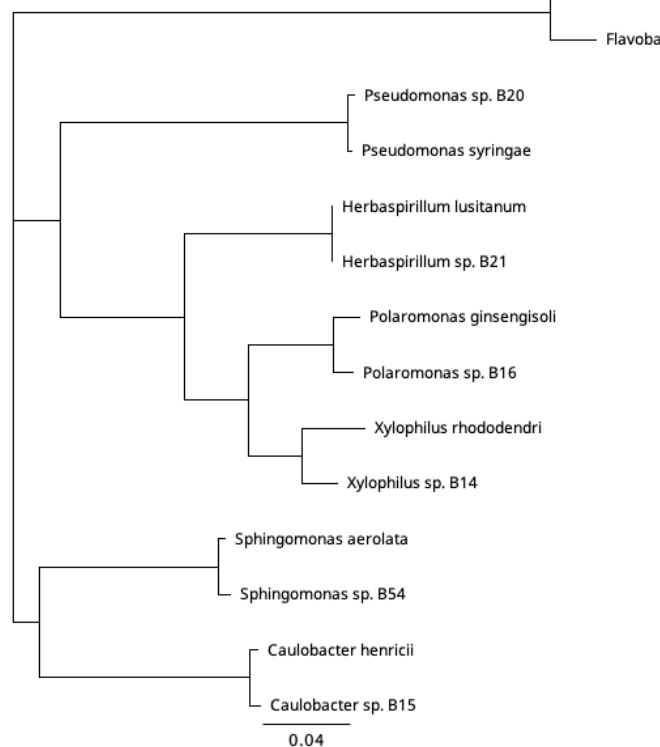
Figure 2. Phylogenetic relationship based on partial 16S rRNA sequence among the studied bacteria isolated from a freshwater sample collected during ice cover. Best similarity hits to bacterial strains with species names were included in the analysis (species strain:accession: Caulobacter henricii ATCC 15253: AJ227758, Flavobacterium collinsii 983-08: HE612088, Herbaspirillum_lusitanum _P6-12: AJHH01000137, Polaromonas ginsengisoli Gsoil 115: AB245355, Pseudomonas syringae KCTC 12500: KI657453, Sphingomonas aerolata NW12: AJ429240, Xylophilus rhododendri CJ1-R5: MN912104 Align- ment Clustal Omega, Neighbor-joining method in Geneious Prime 2022.2. (Biomatters Ltd.).